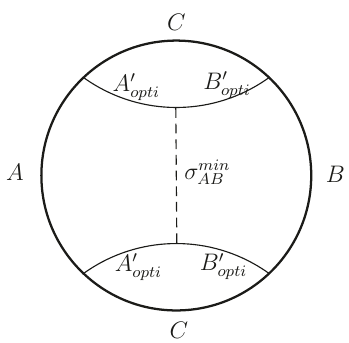
Figure 1 . Sketch of HEoP. A; B are two non-overlapping regions on the boundary @M . The entanglement wedge r AB is the region surrounded by A , B , A 0 minimal cross section on r AB